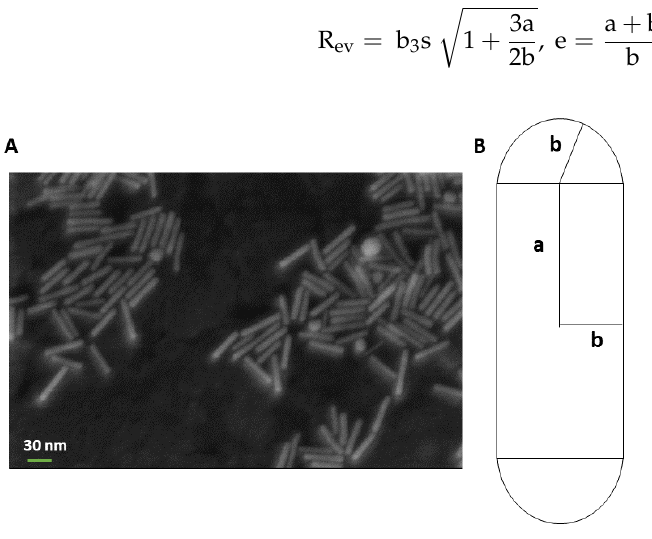
Figure 3. ( A ) TEM image of GNRs and ( B ) geometric model of s-cylinder [61].